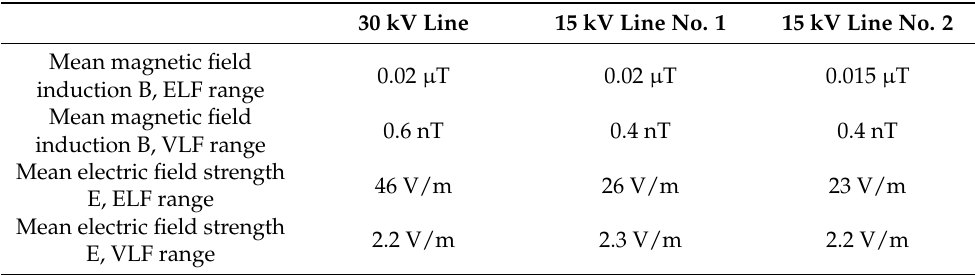
Table 1. Mean magnetic field induction B and electric field strength E values in the ELF and VLF frequency ranges near the studied lines—field background measurement.